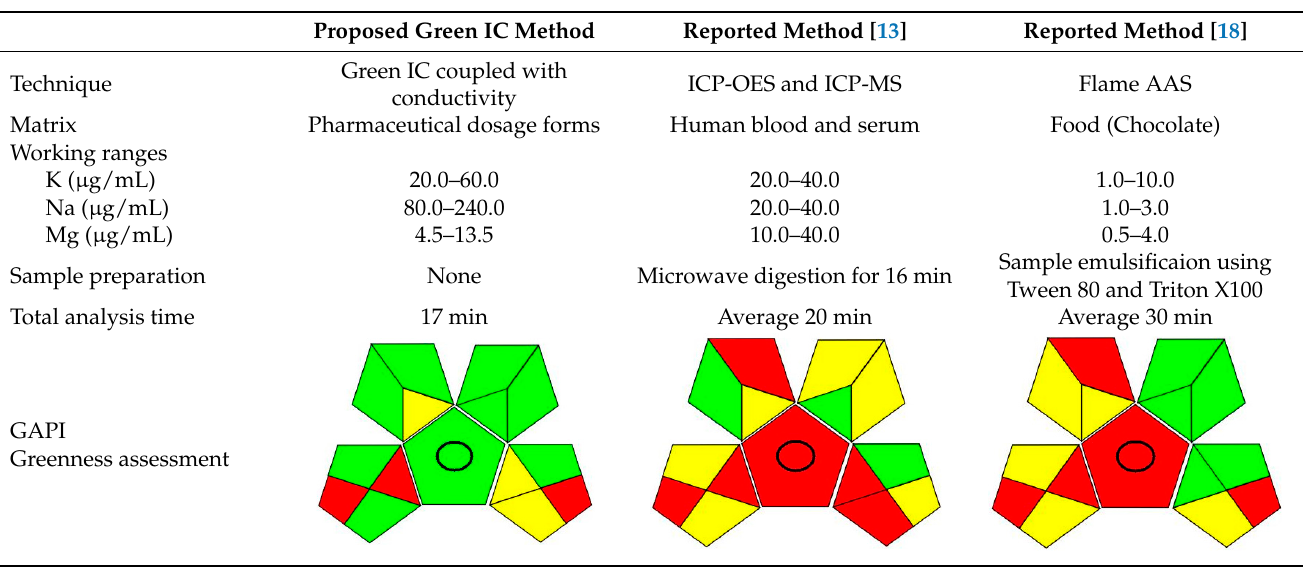
Table 5. Evaluation of the proposed method against reference methods